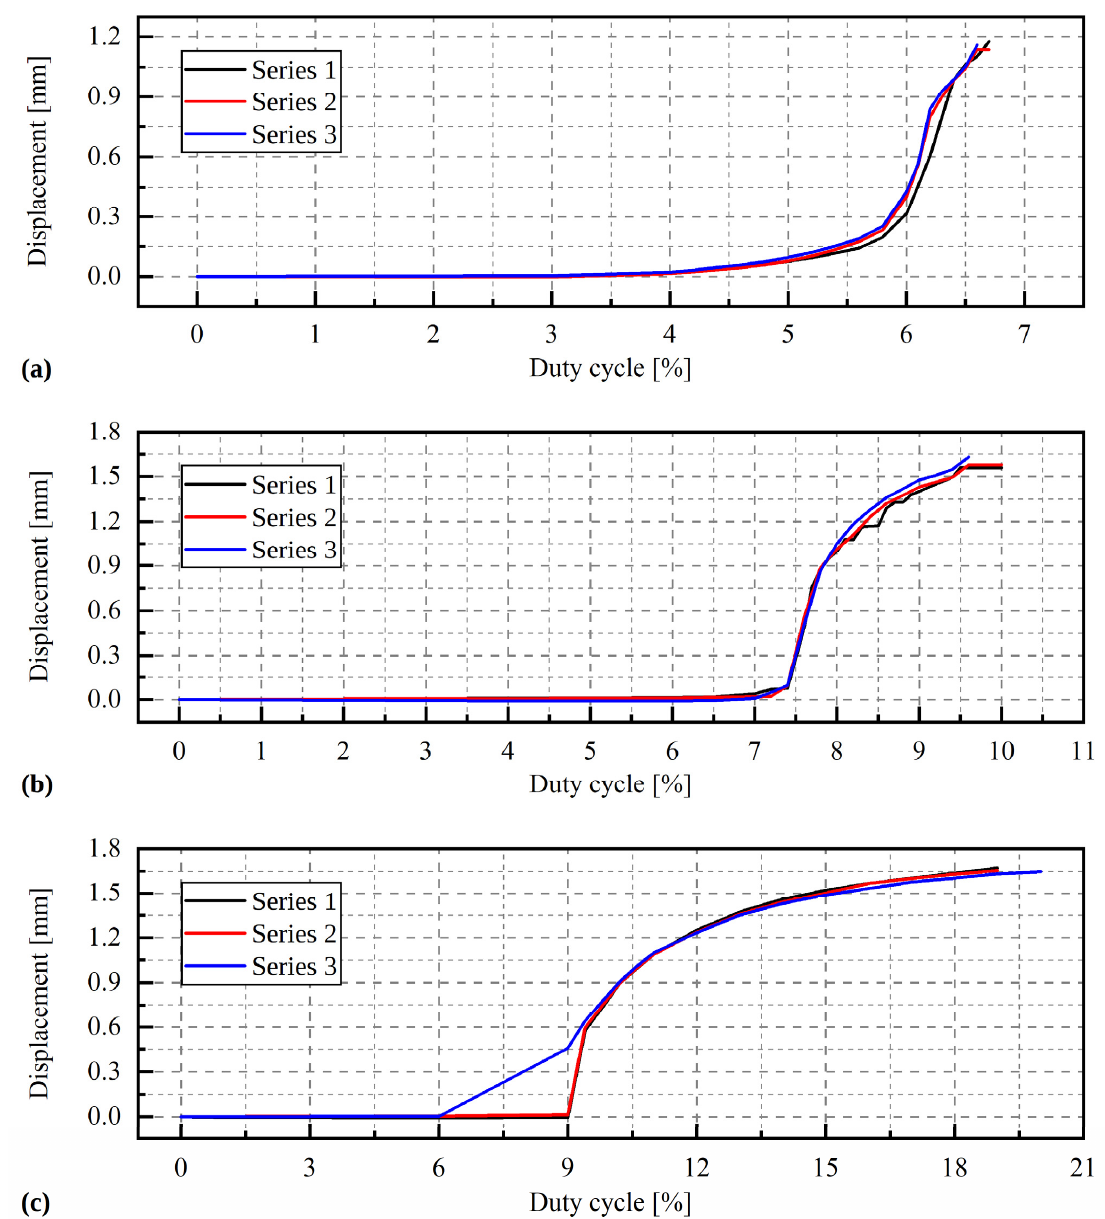
Figure 8. Graphs showing displacement versus time ( a ) for load 0 N; ( b ) for load 9.81 N, and ( c ) for load 19.62 N.